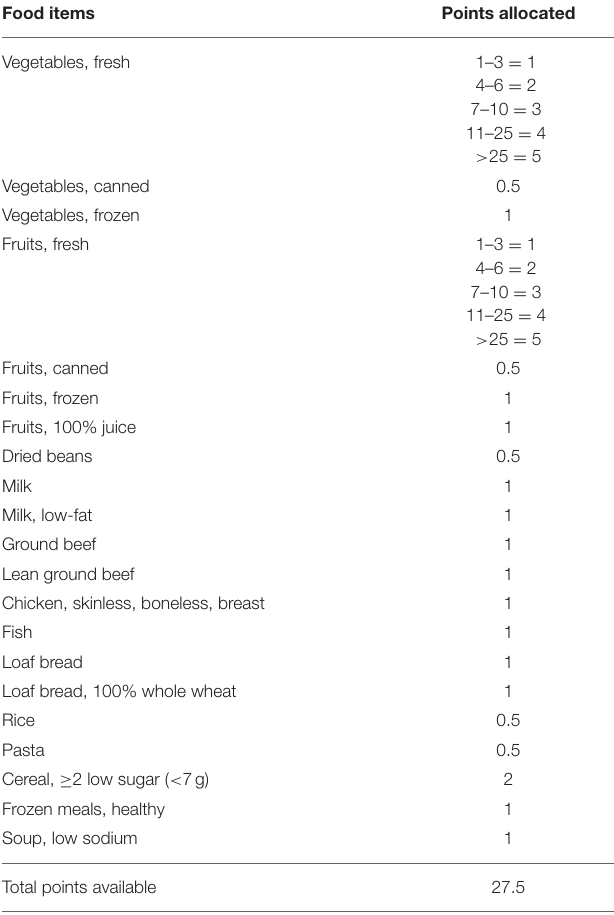
TABLE 1 | Scoring methodology used in the healthy food availability index. Food